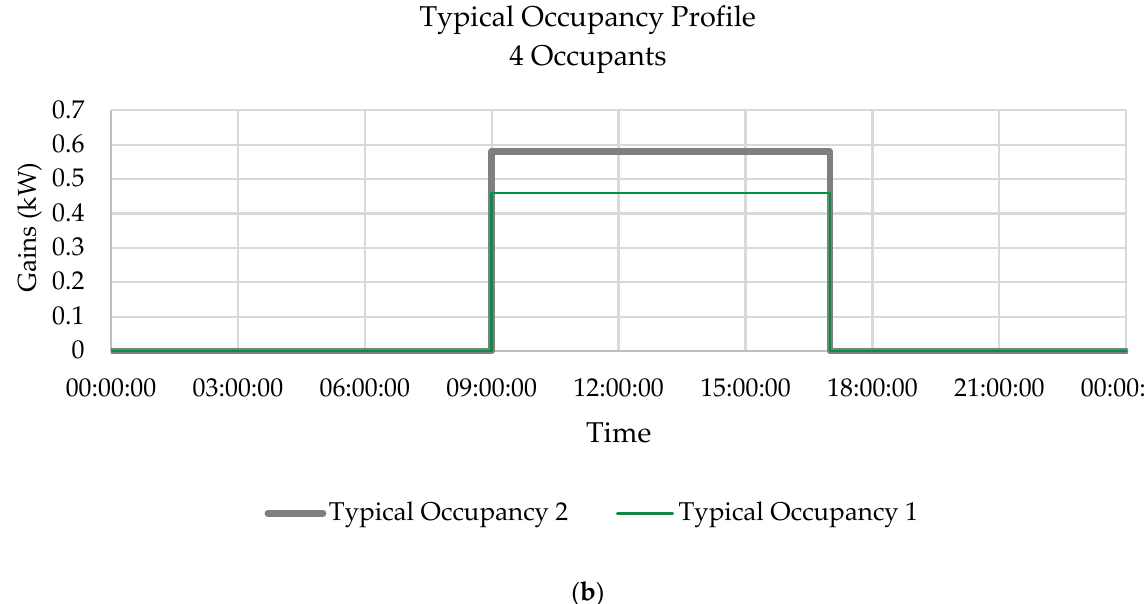
Figure 8. Typical daily static profiles. ( a ) Equipment profile. ( b ) Occupancy profile with Typical Office 1 for constant sitting (average conditions) and Typical Office 2 for constant walking (maximum conditions).